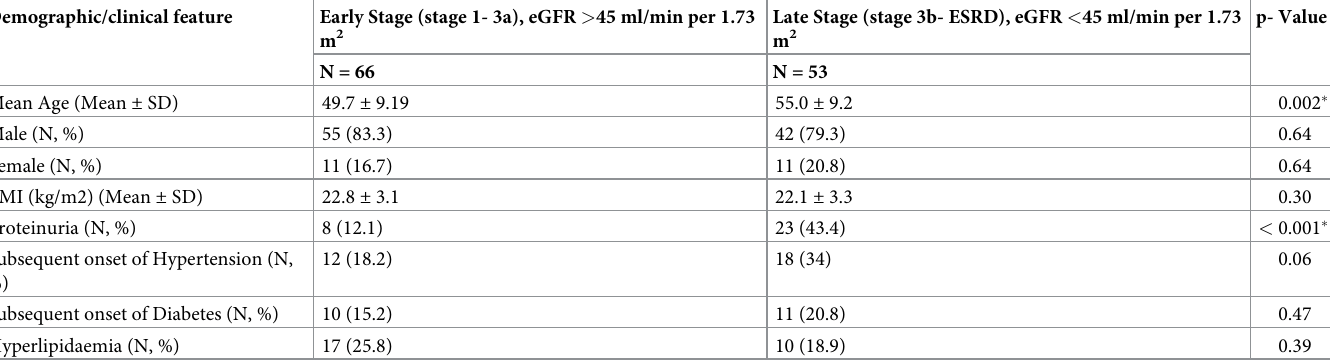
eGFR -estimated Glomerular Filtration Rate, ESRD End-Stage Renal Disease, N-Number, BMI body mass index, Subsequent onset of hypertension and diabetes- hypertension and diabetes developed after the diagnosis of CKDu. Continuous variables are presented as mean ± SD, followed by two sample T-test, Categorical data are presented as numbers (n) of patients and percentages followed by two proportion test, � Significance level p <